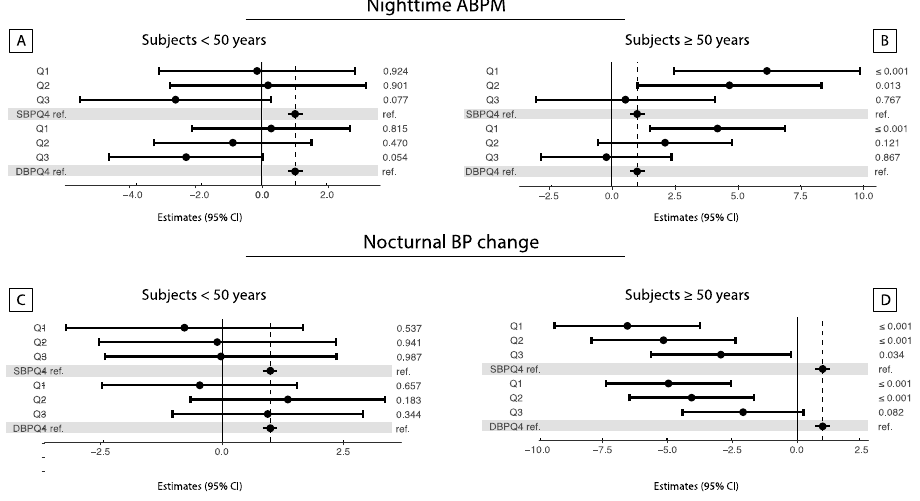
Figure 2. Forest plot of the linear regression analyses exploring the association between the daytime/nighttime urinary sodium excretion ratio and nighttime ( A , B ) and nocturnal BP changes ( C , D ) by age group. Analyses were performed by daytime/nighttime urinary sodium excretion ratio quartile categories, (Q4 as reference) and by age groups ( ≥ 50 years, 589 individuals and <50 years, 473 individuals). β -estimates and 95% confidence intervals were reported. Gray dotted lines represent the reference value. All models were adjusted for: age, gender, body mass index, smoking, use of antihypertensive medications, diuretics, previous cardiovascular diseases, dietary salt consumption, Supplementary Materials Figure